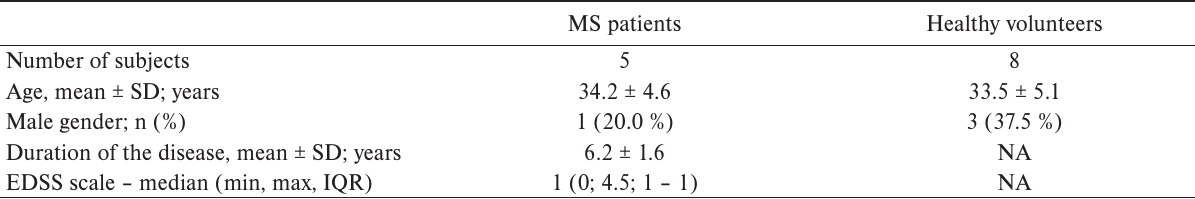
Table 1. Demografic data of enrolled subjects.